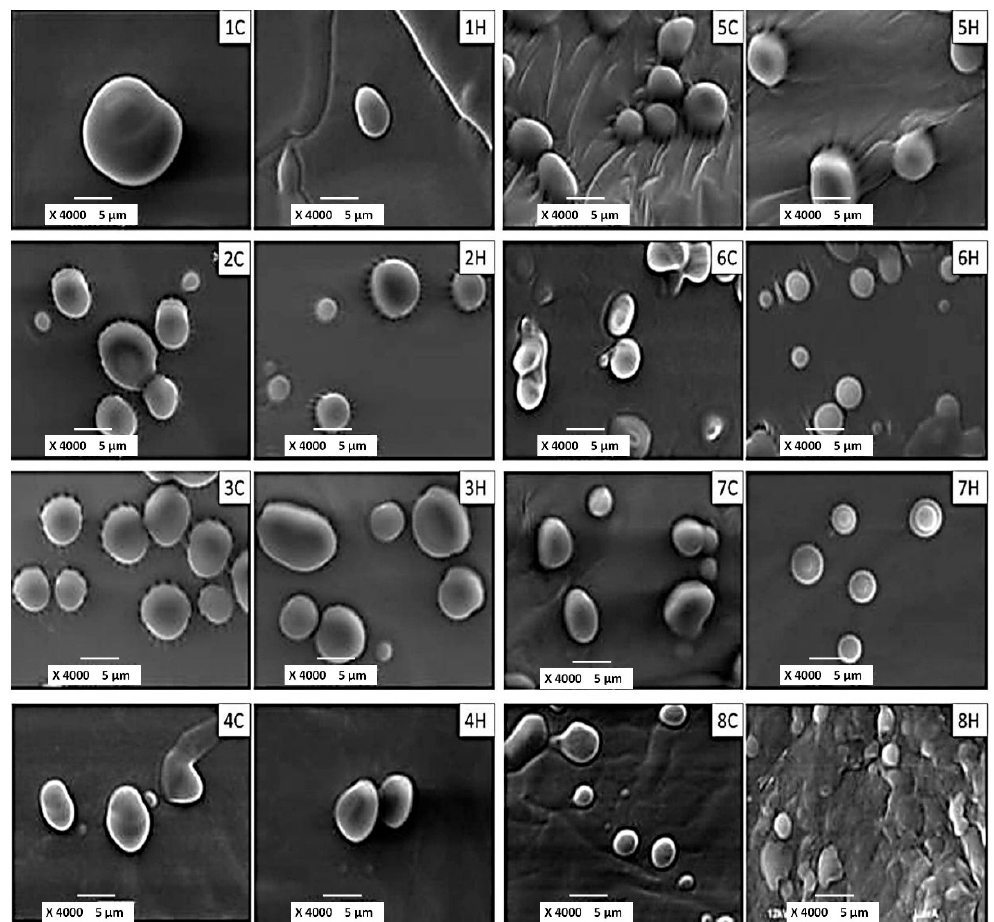
Figure 1. Scanning Electron Microphotographs of ethosomal systems produced under different processing conditions.